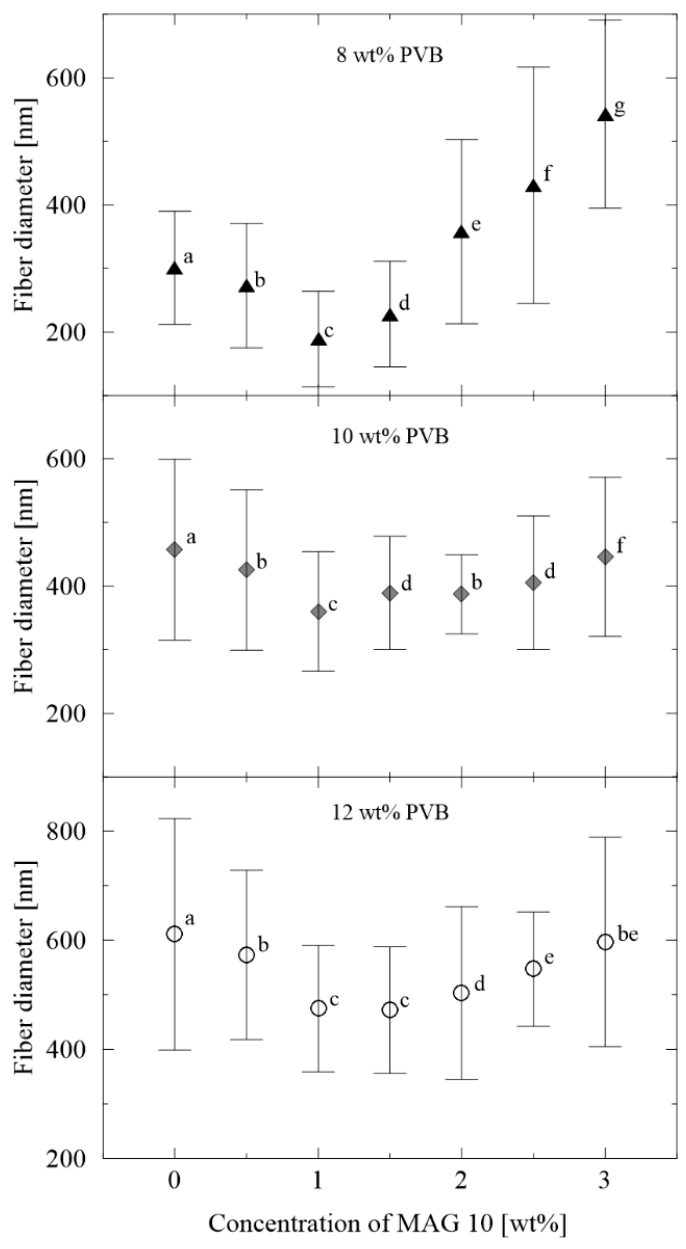
Figure 4. Fiber diameter vs. concentration of MAG 10. The various letters indicate significant differences ( p < 0.05) between the samples.